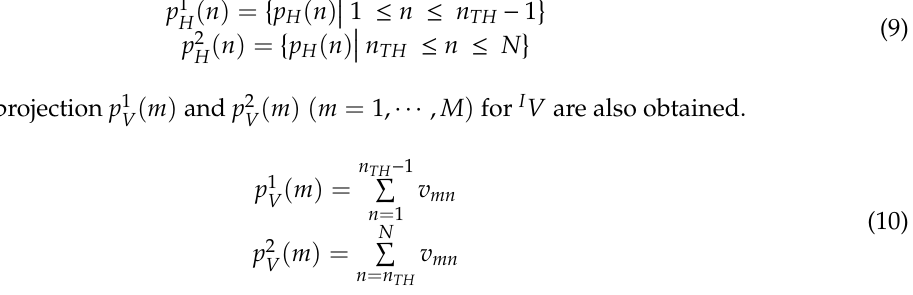
Figure 8. Solder region extraction of SMT chip image where ‘px’ refers to pixels: ( a ) chip component image, ( b ) gray scale image showing horizontal split of chip component, ( c ) vertical and horizontal projections, and ( d ) result of solder region extraction.